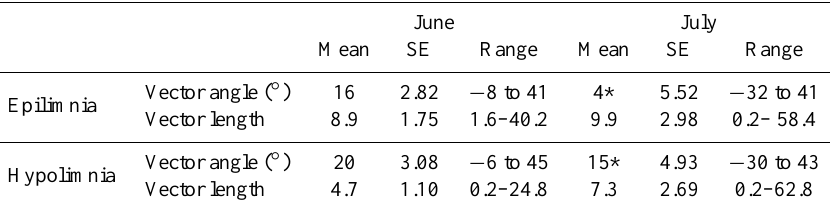
Table 2. Nutrient Limitation and C acquisition as indicated by mean vector angle and length for both months. Significant changes ( p ≤ 0.05) between June and July means are indicated by asterisk (*). SE: standard